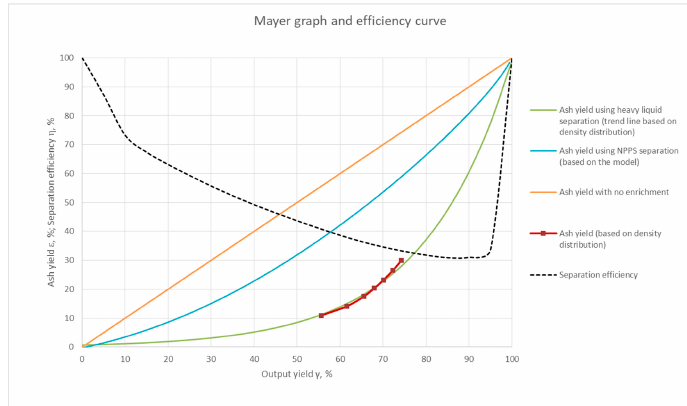
Figure A8. Summary of washability curves, enrichment curves, experimental results and modelling results—feed material no. 5 in grain size class 0–20 mm.